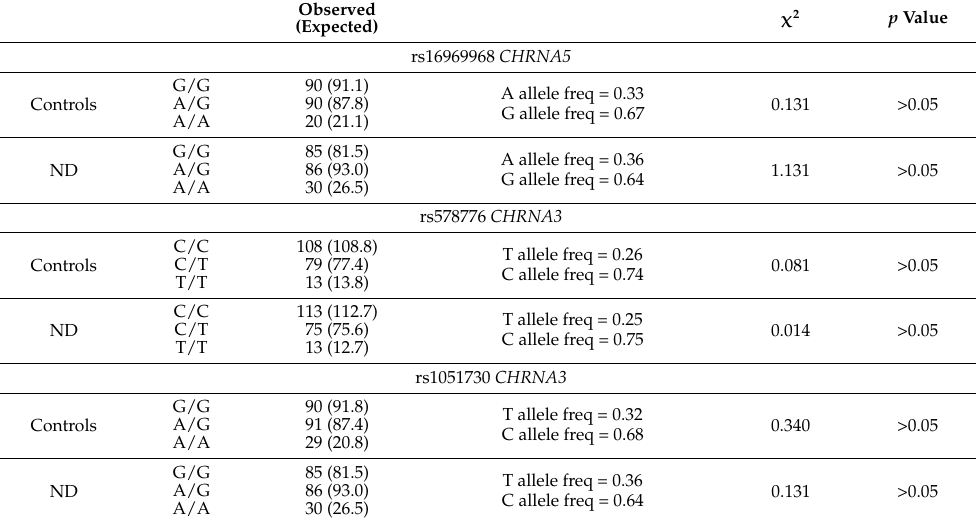
Table 1. Hardy–Weinberg equilibrium of the CHRNA5 rs16969968, rs578776 CHRNA3, and rs1051730 CHRNA3 in the group of nicotine-dependent (ND) subjects and